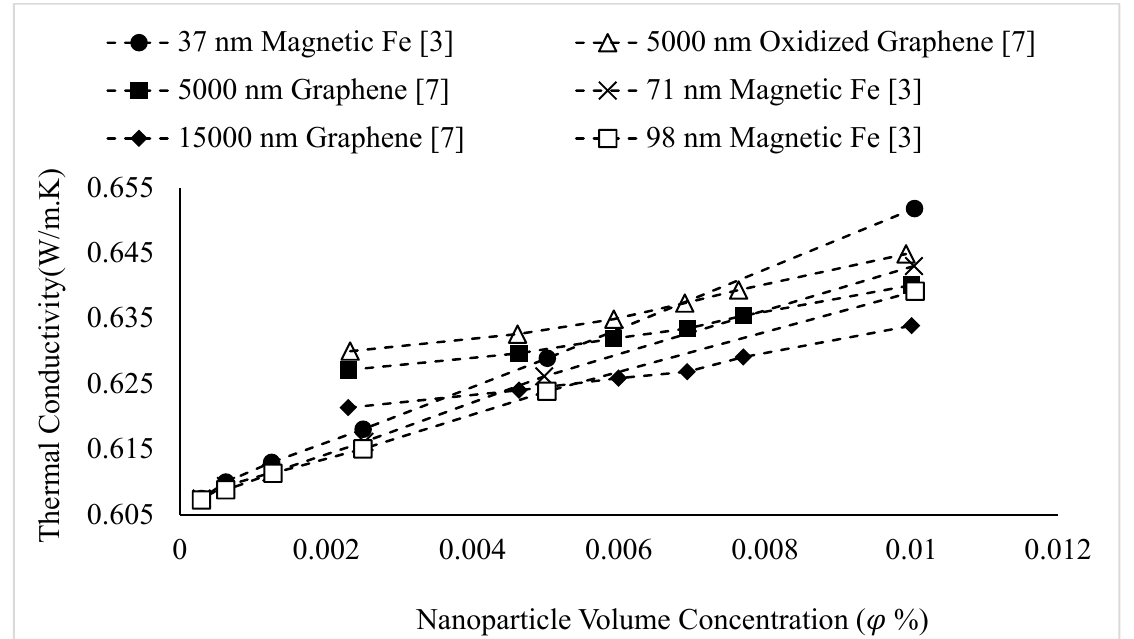
Figure 2. Variation of water-based nanofluid thermal conductivity as a function of nanoparticle volume concentration, 𝜑 , for different nanoparticles at room temperature.